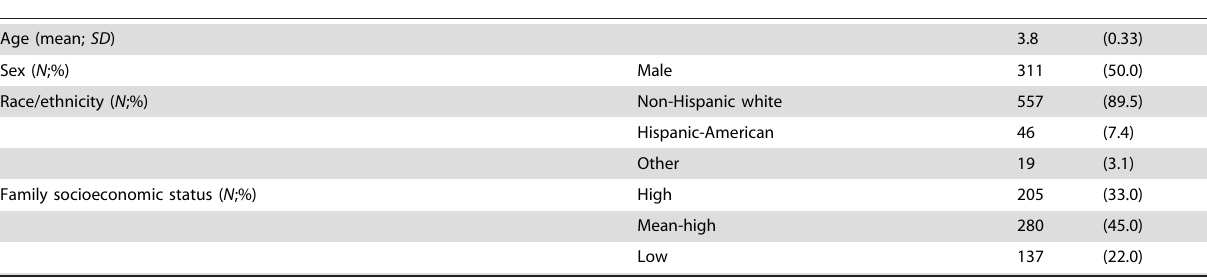
Table 1. Demographic Characteristics of the Sample ( N